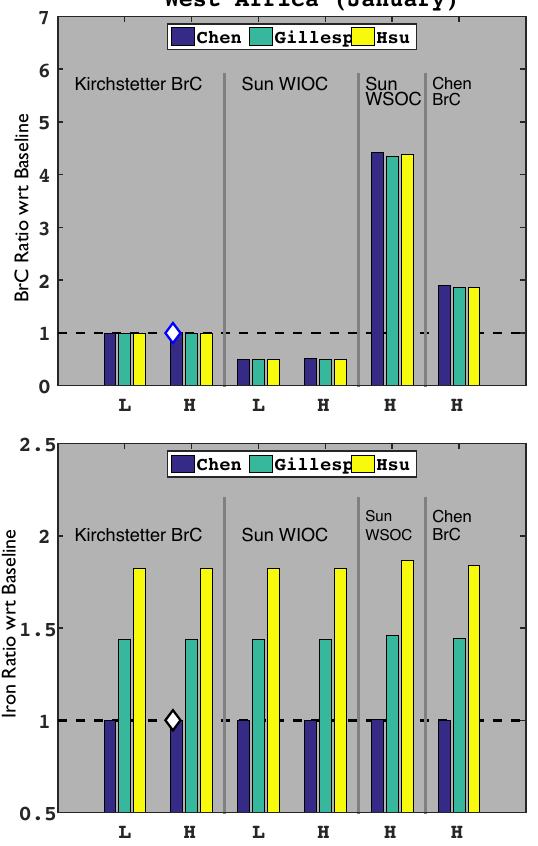
Figure 12. Same as Fig. 11, except y axis is BrC (top panel) and free iron (bottom panel) relative